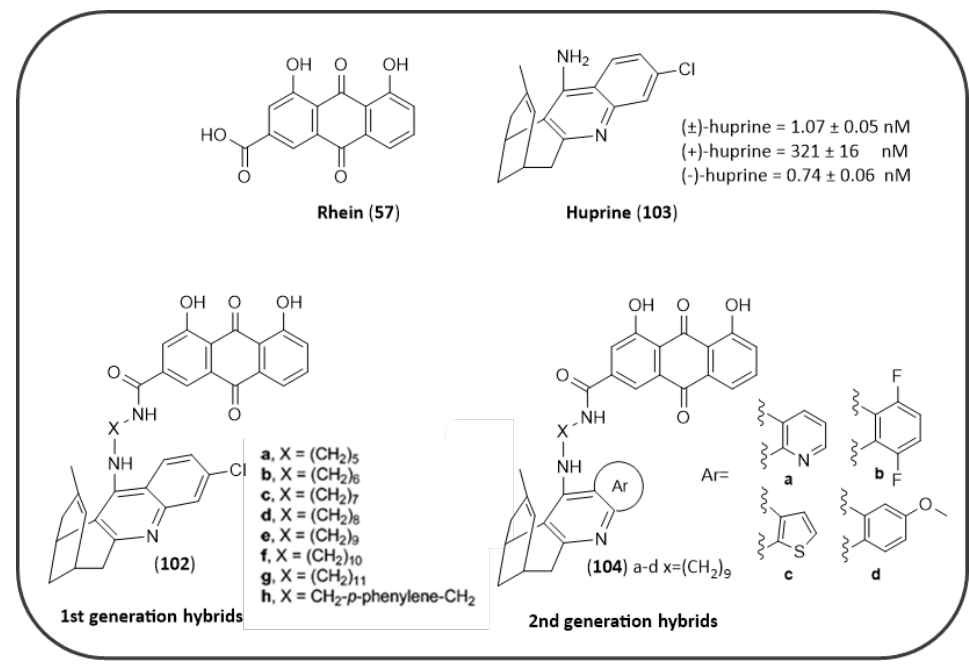
Figure 21. Representative rhein-huprin